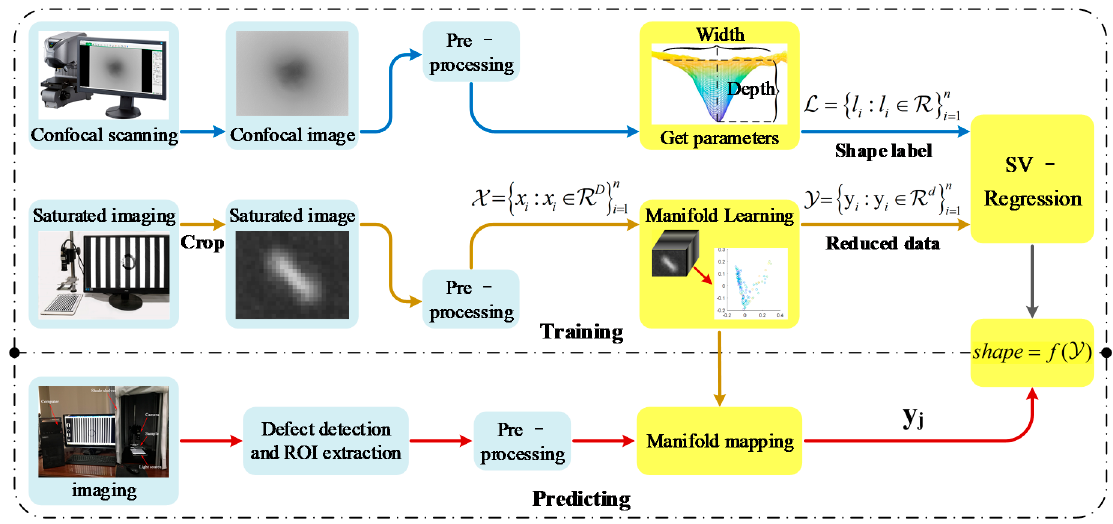
Figure 4. Saturated imaging grey level varies with defect depth.